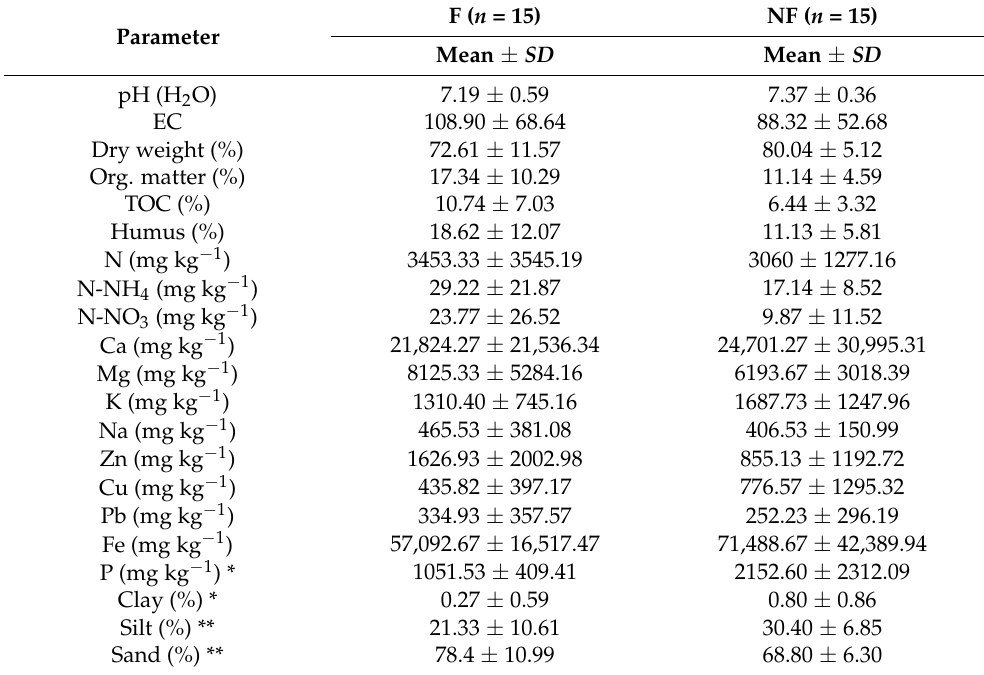
Table 4. Physicochemical characteristics of the soils on F and NF plots (means, standard deviations, and range). The statistical differences between means were marked by the asterisk next to the name of the variable according to the Mann–Whitney U test (*— p ≤ 0.05; **— p ≤